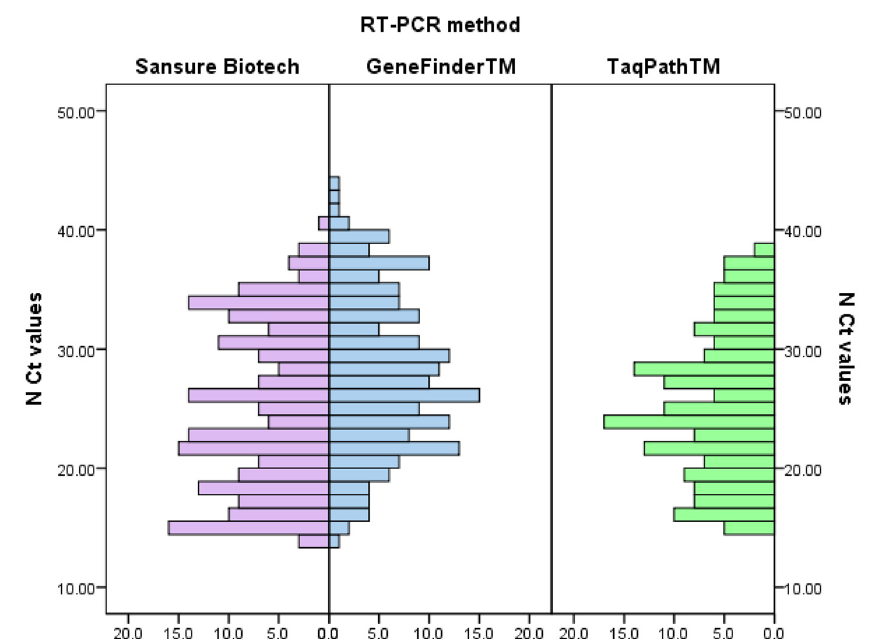
Figure 1. Distribution of Ct values that refer to amplification of ORF1ab gene according to the ap- plied method.